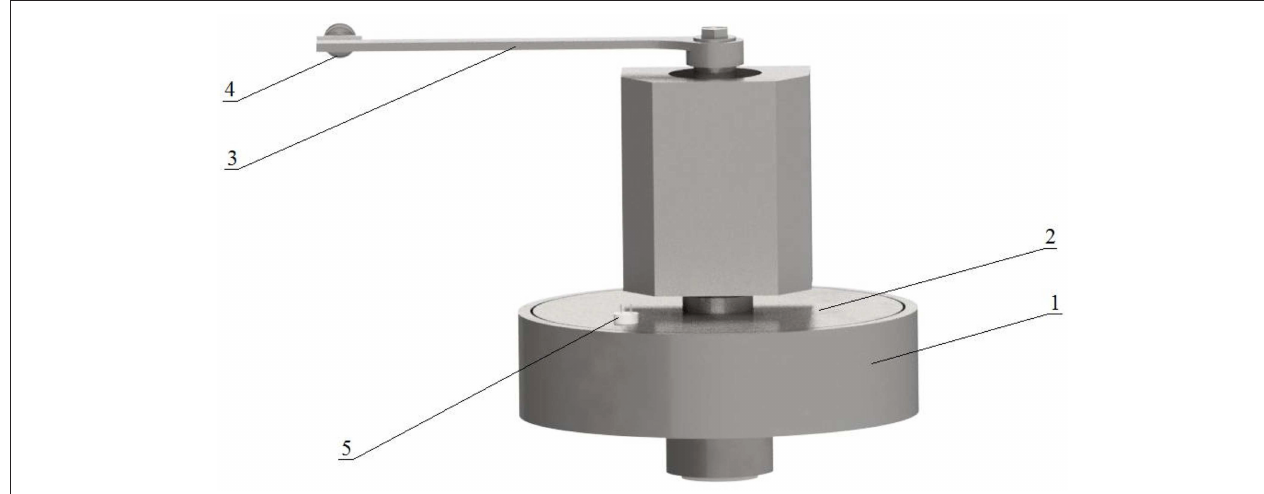
FIGURE 2 | Scheme of the viscous clutch of the measurement device: 1, cylinder set on the motor’s shaft; 2, cylinder connected to a lever; 3, lever; 4, force sensor; 5, temperature sensor output.